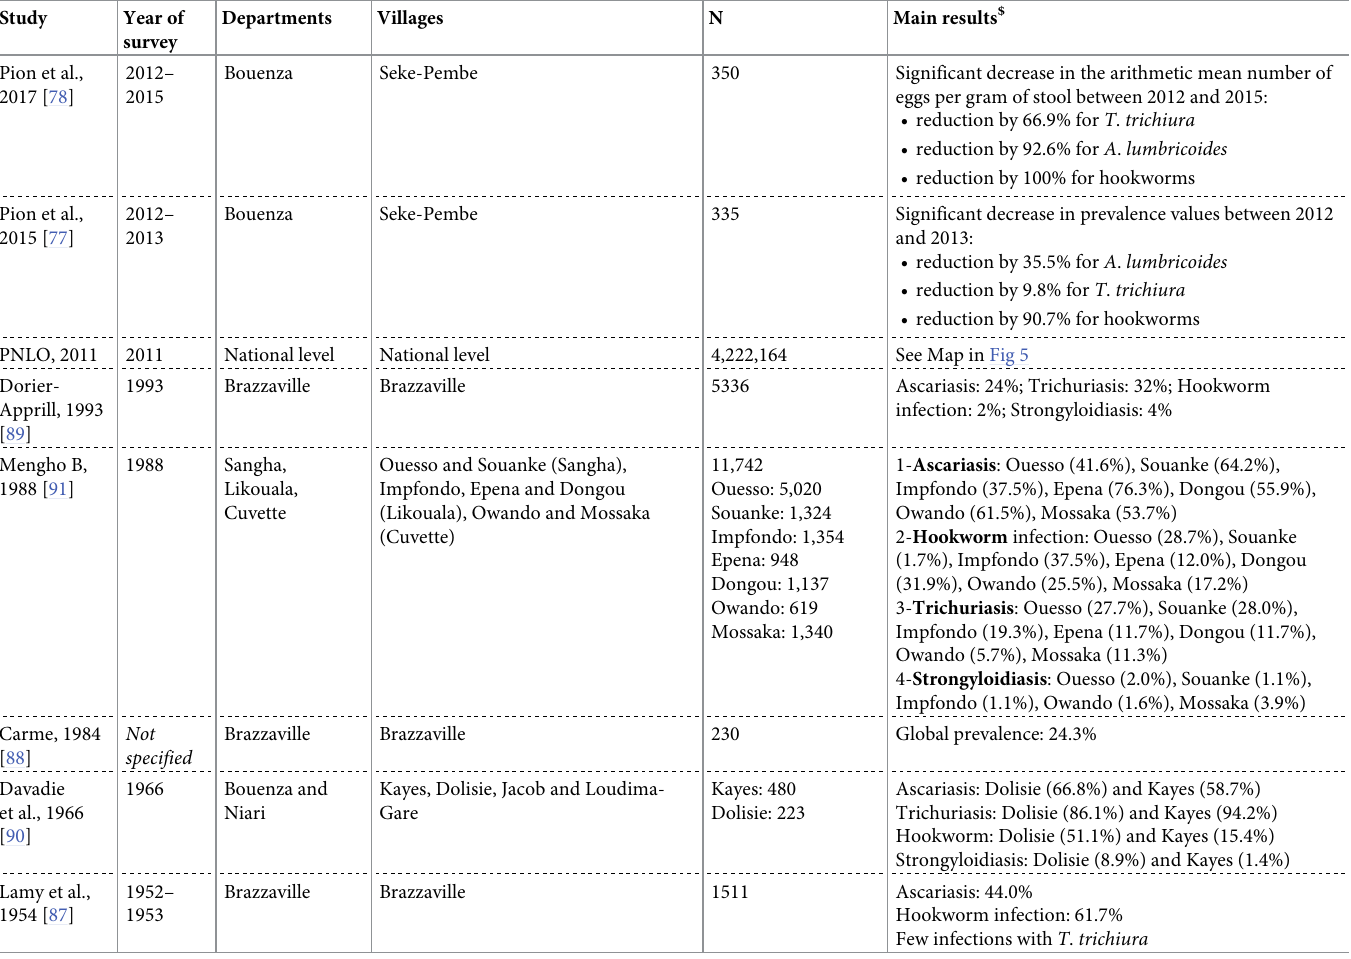
Table 3. Summary of the included epidemiological studies and reports for